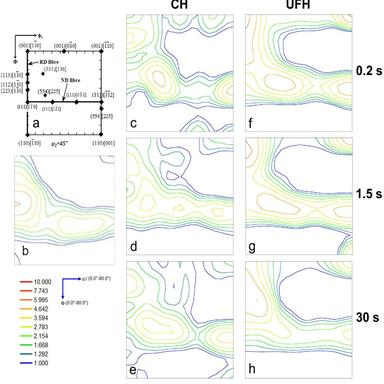
Effect of heating rate and soaking time on the orientation distribution function (ODF) of the studied material for φ2 = 45° in the Euler space; a) ideal BCC texture components for φ2 = 45° in the Euler space; b) ODF of the initial cold rolled material, reproduced from; c), d) and e) ODF corresponding to the CH conditions annealed for 0.2, 1.5 and 30 s, respectively; f), g) and h) correspond to the UFH conditions soaked for 0.2, 1.5 and 30 s, respectively.